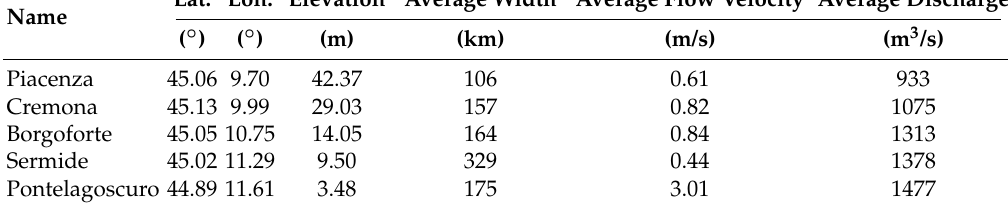
Table 3. The location and height of available in situ data along the Po River. The height refers to the mean water level derived from daily time